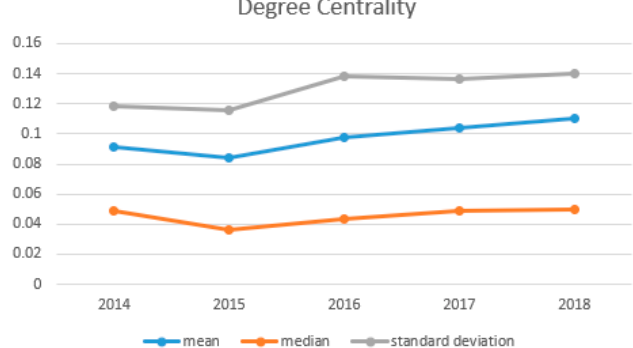
Figure 3. Degree cumulative distribution curve during 2014–2018. Figure 3 contains five graphs, which are arranged by year as: ( a ) 2014, ( b ) 2015, ( c ) 2016, ( d ) 2017, ( e ) 2018.